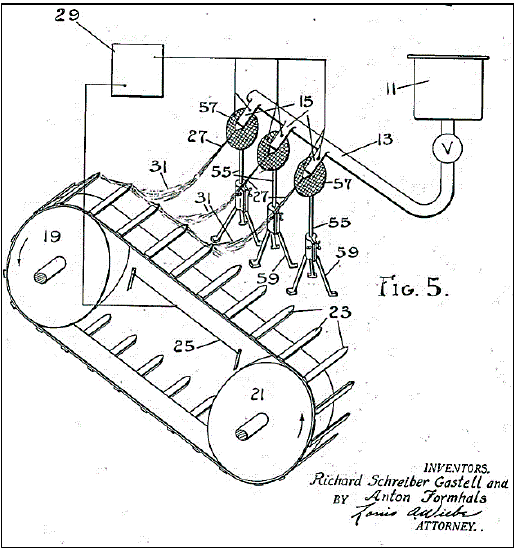
Figure 2. Electrospinning setup by A. Formhals [ 11 ] .